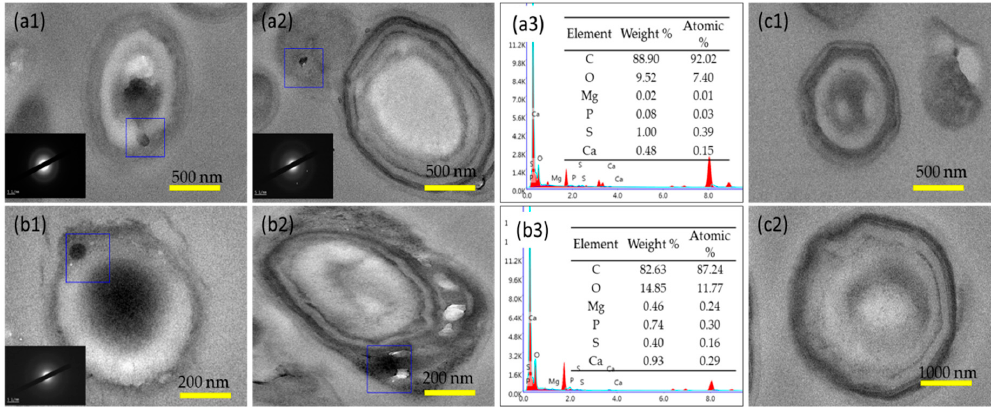
Figure 9. HRTEM images of the ultrathin slices of S. warneri YXY2 cells cultivated for 14 days ( a1 , a2 ): cells in the experimental group at Mg/Ca ratio of 0; a3: EDS analysis of the dark inclusion marked by the blue square in a1; ( b1,b2 ): cells in the experimental group at Mg/Ca ratio of 8; b3: analysis of the dark inclusion marked by the blue square in b1; ( c1,c2 ): cells in the medium without any Ca 2+ and Mg 2+ ions).